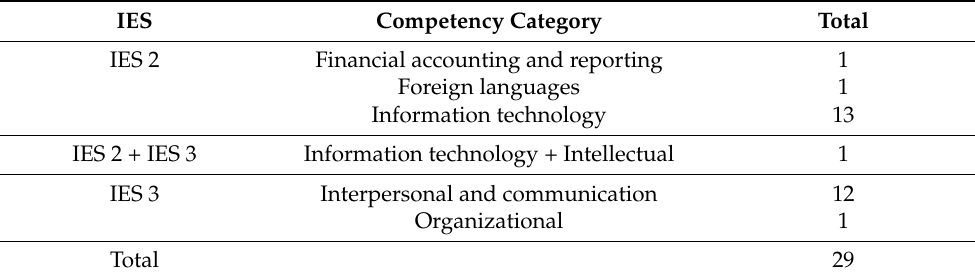
Table 8. Study frequency of competency categories.